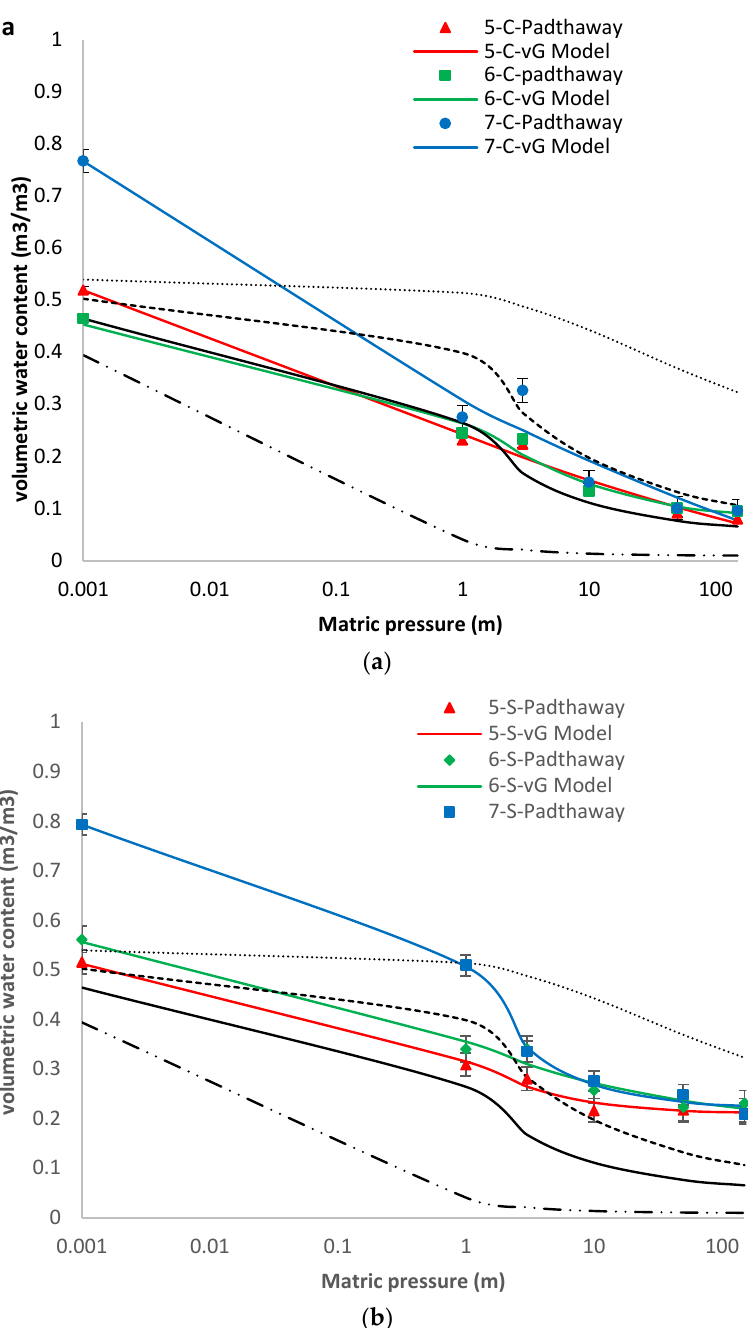
Figure 6. Water retention curve of biochars with van Genuchten models fitted from ( a ) grapevine cane biochar, ( b ) grapevine stalk biochar. Error bars denote standard error.